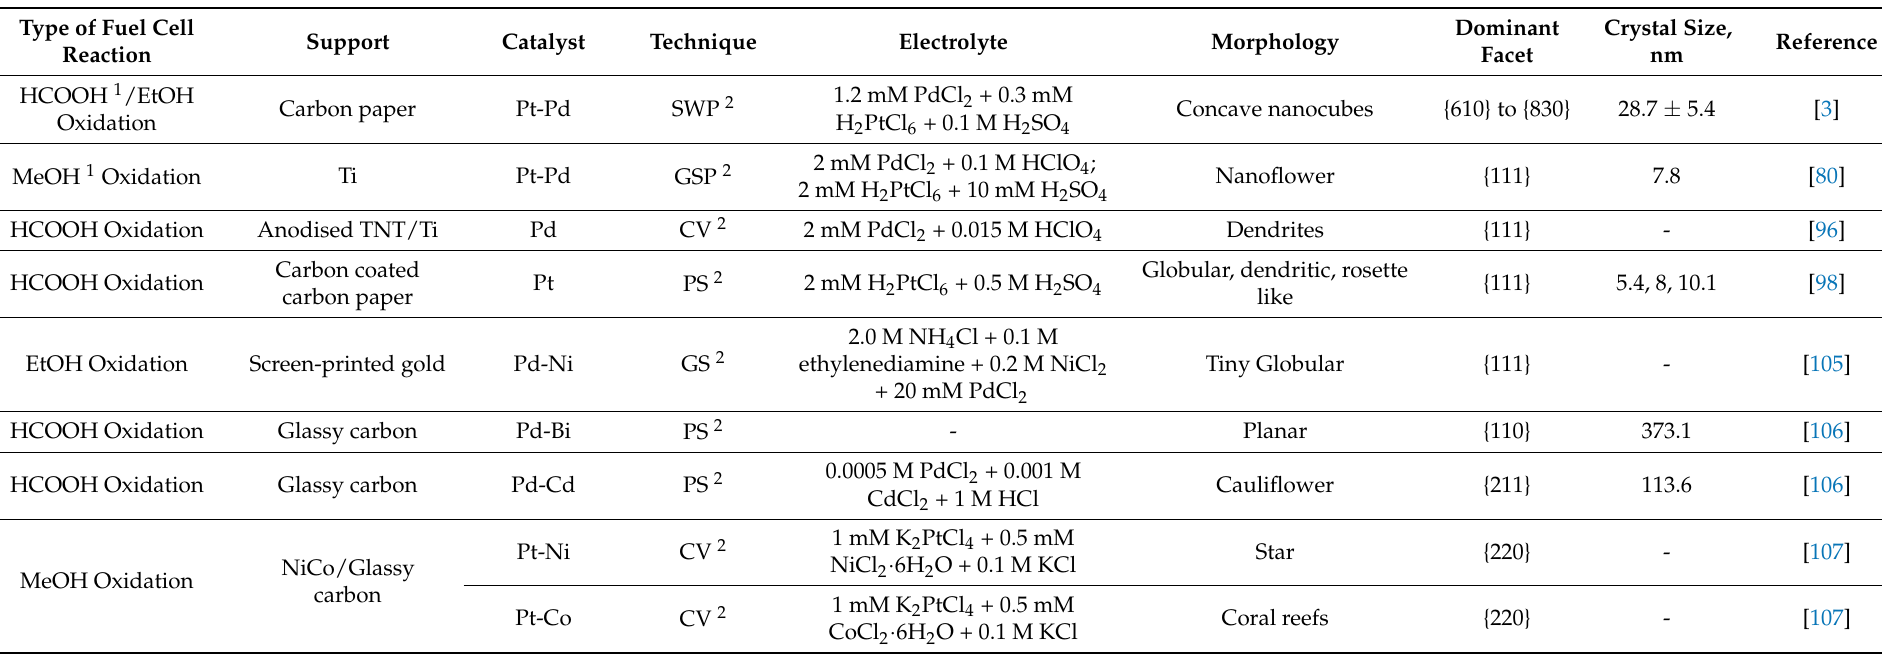
Table 4. Electrodeposition of Pt and Pd on different support employed for the oxidation of organic molecules in three electrode electrochemical